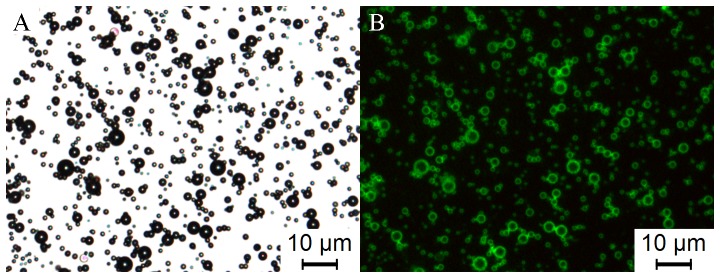
The bright field and fluorescence images of FITC-labelled Stearic-PEI600 cationic MBs.(A) Bright field image and (B) fluorescent image of MBs containing 5% Stearic-PEI600. Scale bars: 10 µm.